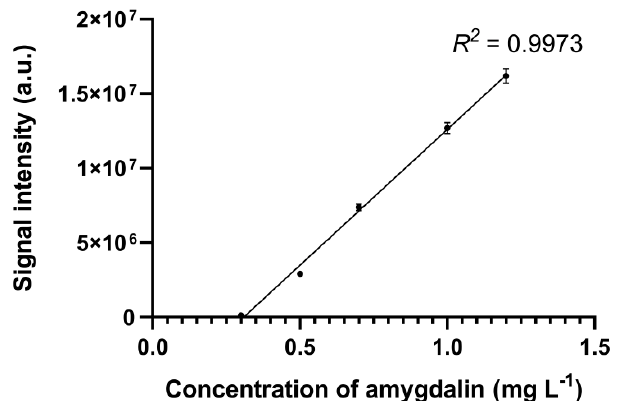
Figure 13. Dependence of signal intensity vs. amygdalin concentration in the sample.